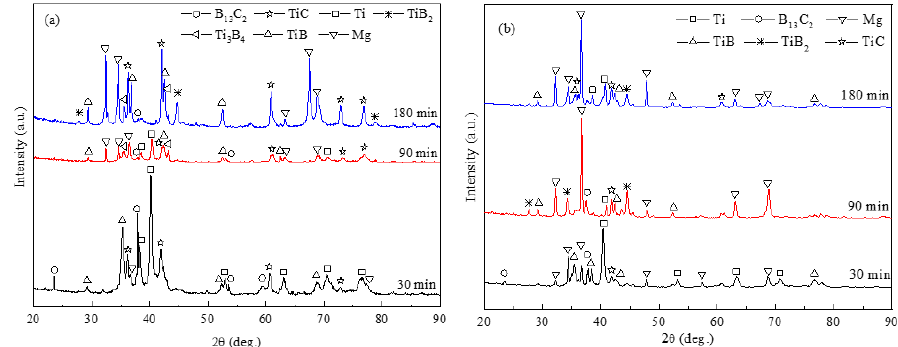
Figure 3. XRD spectra of (B 4 C+Ti)/Mg ( a ) and (B 4 C+Ti)/AZ91D ( b ) composites prepared for different holding time.